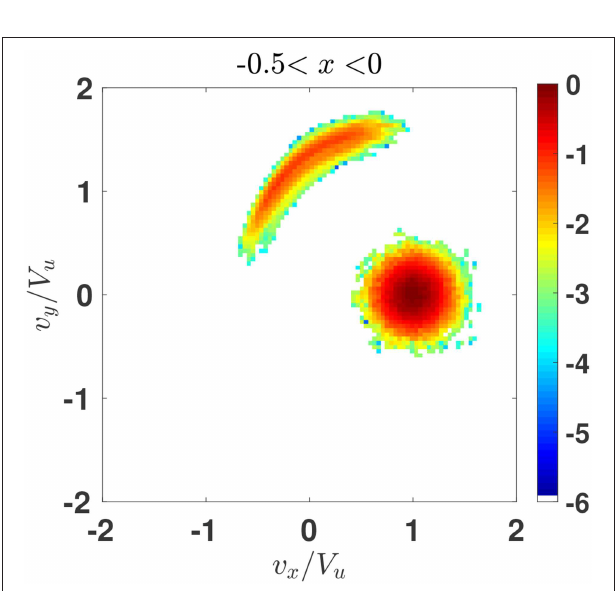
v y , accumulated in the −